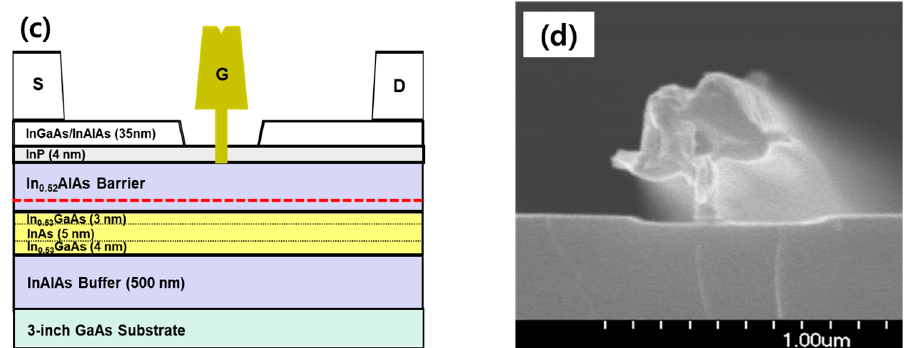
Figure 1. ( a ) Epitaxial structure of the In 0.53 Ga 0.47 As/InAs/In 0.53 Ga 0.47 As composite channel HEMT structure on a GaAs substrate. ( b ) Energy band diagram of the epitaxial structure ( c ) Schematic of the In 0.53 Ga 0.47 As/InAs/In 0.53 Ga 0.47 As composite channel HEMT on a GaAs substrate ( d ) SEM image of the fabricated T-gate.